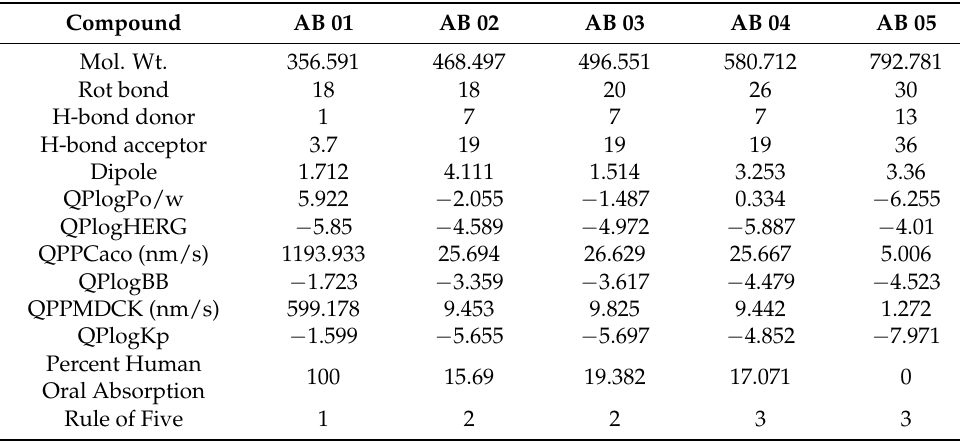
Table 1. Data obtained from ADMET prediction.